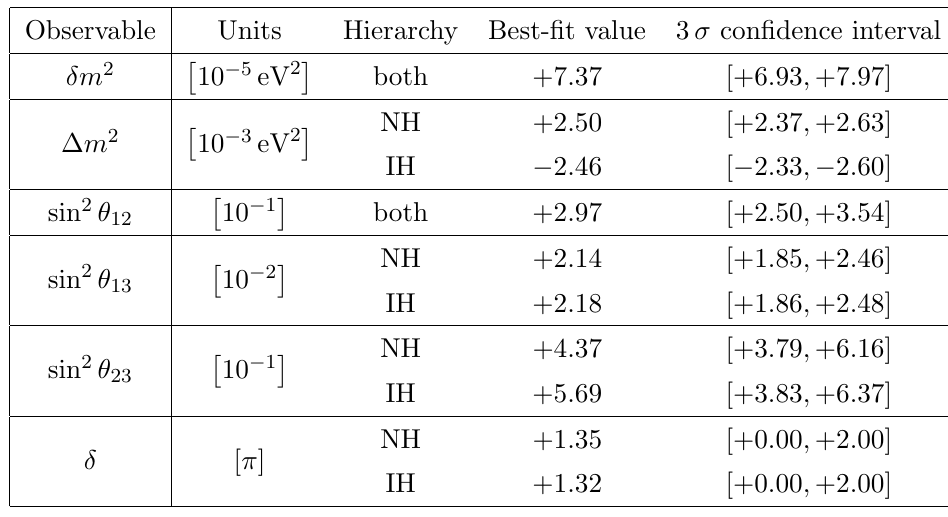
Table 1 . Best-(cid:12)t values and 3 (cid:27) con(cid:12)dence intervals for the (cid:12)ve low-energy observations that are currently accessible in experiments ( (cid:14)m 2 , (cid:1) m 2 , sin 2 (cid:18) 12 , sin 2 (cid:18) 13 , and sin 2 (cid:18) 23 ) as well as for the CP -violating phase (cid:14) [43]. Note that, at the 3 (cid:27) level, (cid:14) can still freely vary over the entire range of possible values, (cid:14) 2 [0 ; 2 (cid:25) ).